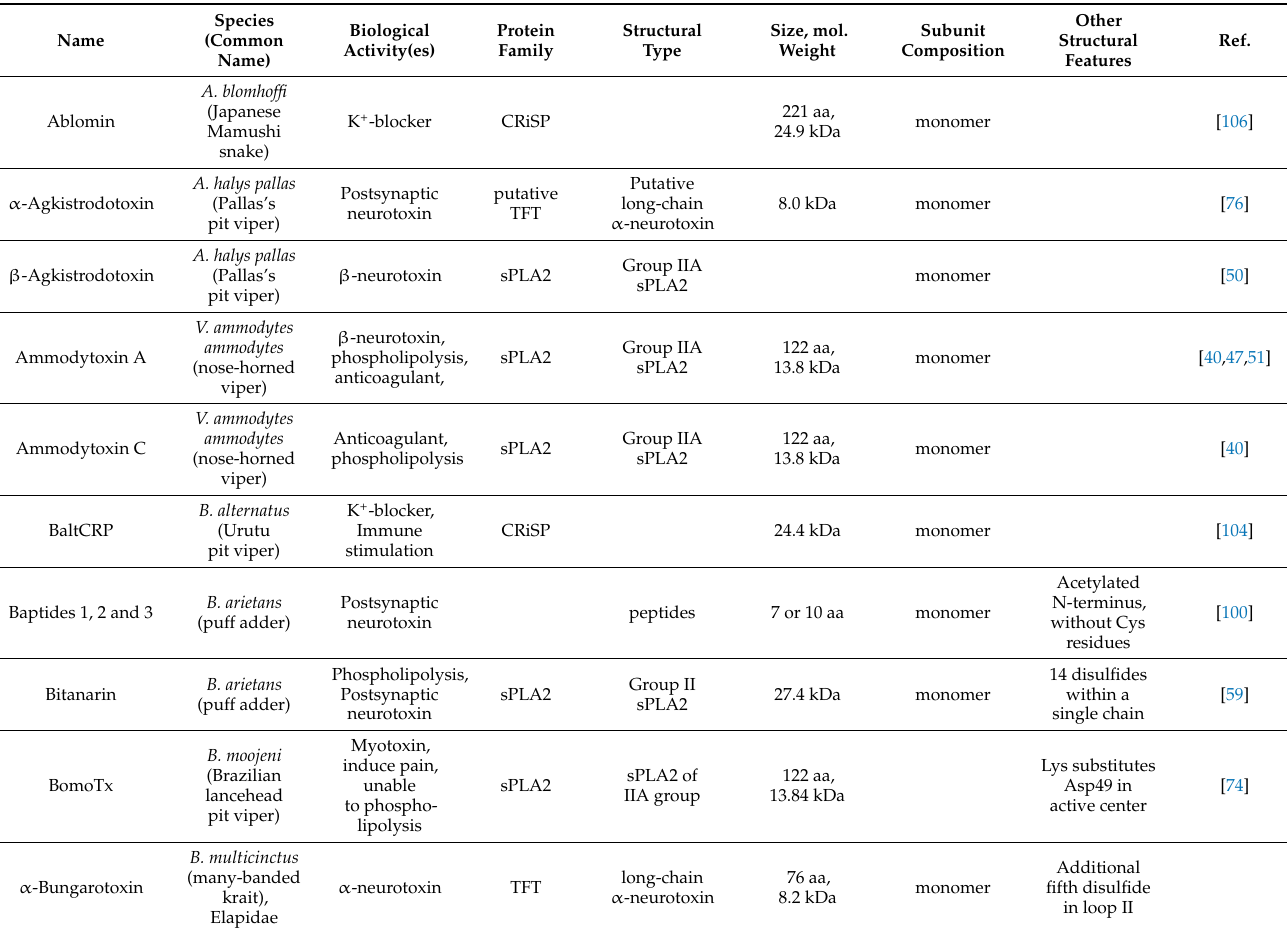
Table 1. Neurotoxins identified in hemotoxic